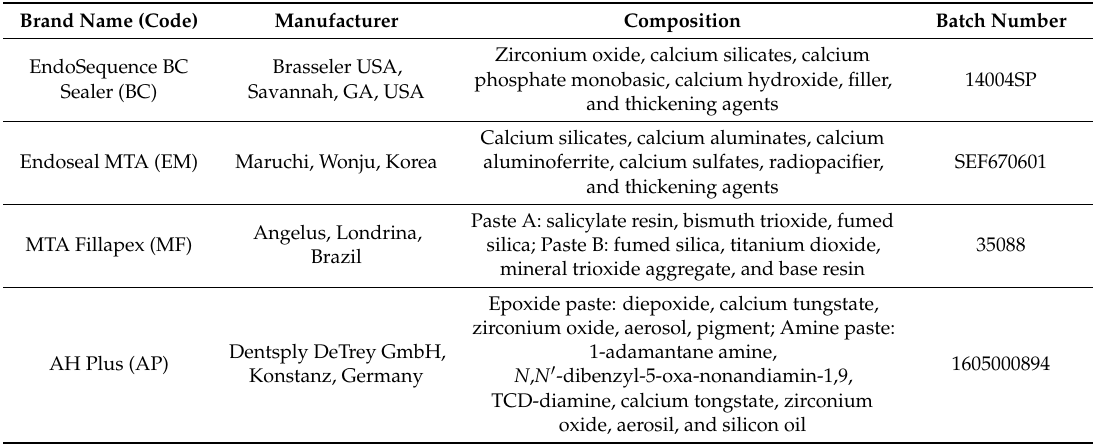
Table 1. Root canal sealers